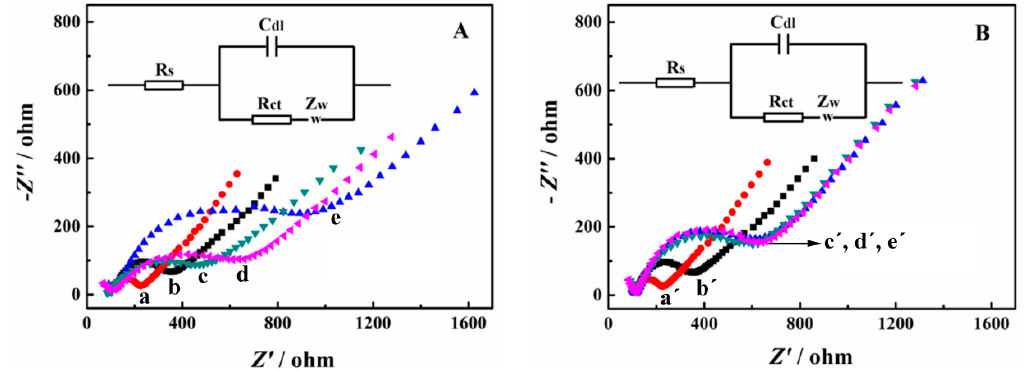
Figure 5. ( A ) Nyquist plots of an AuNPs/GCE ( a ), a bare GCE ( b ), a MIP- poly[(Cys)VIMBF 4 ]/AuNPs/GCE before ( e ) and after ( c ) removing AFP, and rebinding AFP ( d ); ( B ) Nyquist plots of an AuNPs/GCE ( a´ ), a bare GCE ( b´ ), a NIP-poly[(Cys)VIMBF 4 ]/AuNPs/GCE before ( e´ ) and after ( c´ ) washing, and interacting with AFP ( d´ ) at the concentration of 20.0 ng mL − 1 ; Supporting electrolyte: 5.0 mmol L − 1 K 3 [Fe(CN) 6 ]/K 4 [Fe(CN) 6 ] (1:1) + 0.01 mol L − 1 phosphate buffer (pH 7.4) + 0.1 mol L − 1 KCl solution.